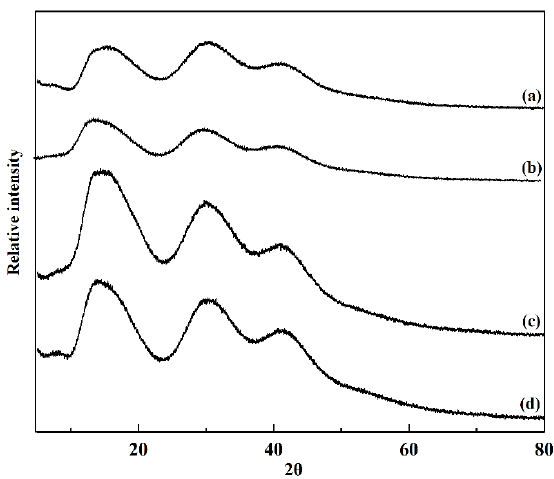
Figure 6. XRD study of: the neat GG (a); and of the GG fibrous mats loaded with TA with: 10% TA (b); 15% TA (c); and 20% TA (d).